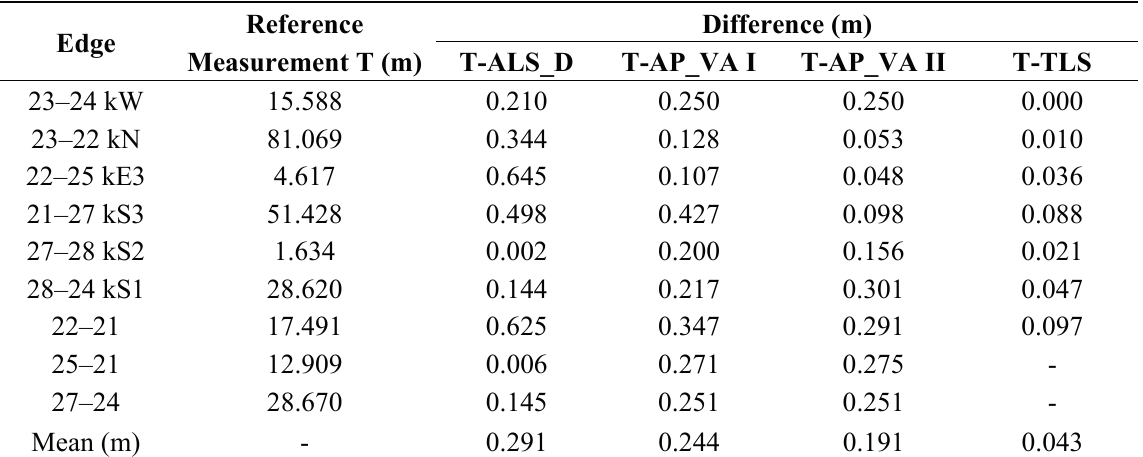
Table 2. Absolute differences in segment lengths respectively reference